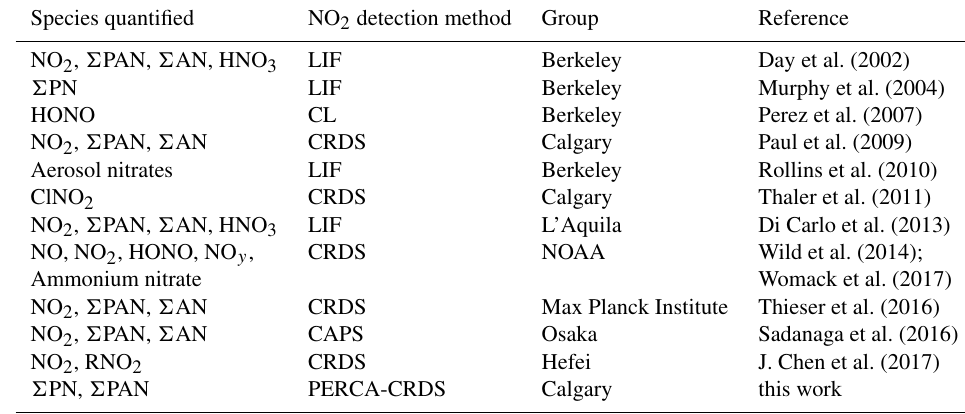
Table 2. Selected thermal dissociation methods for quantification of daytime NO y species. Species